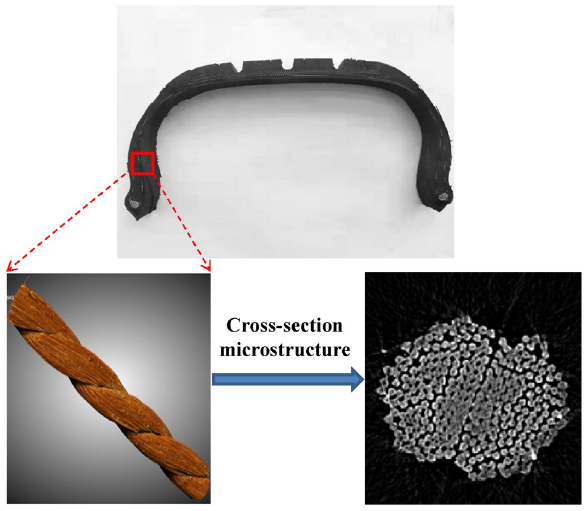
Figure 1. Radial tire structure diagram 2 .